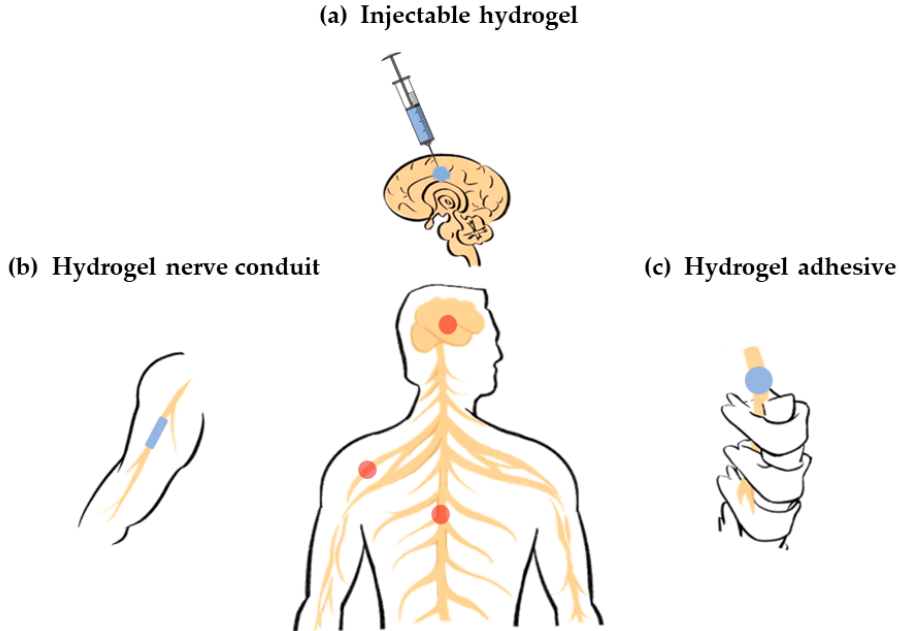
Figure 1. Various hydrogel carriers for nerve repair. ( a ) Injectable hydrogel carriers for brain nerve repair (central nervous system); ( b ) Hydrogel carriers as conduits for peripheral nerve repair (peripheral nervous system); ( c ) Hydrogel carriers as adhesive for spinal cord repair (central nervous system);